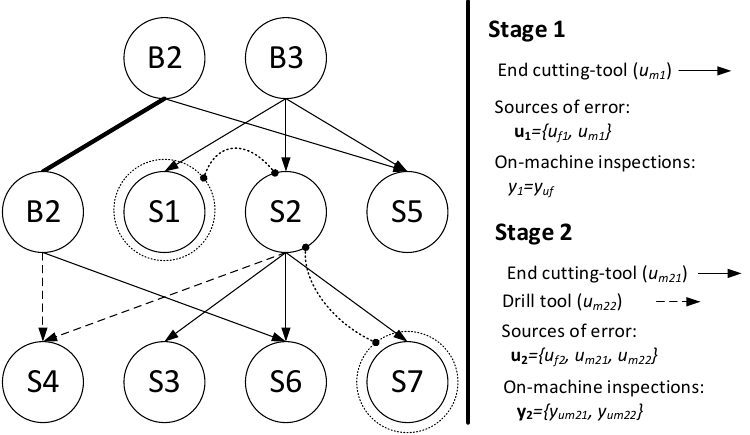
Figure 4. Resulting rooted tree of a previous MMP example. The path related to KPC1 (distance between S1 and S7) is shown in dotted lines to clarify the methodology to obtain the matrix 𝚪 in the text. B2–B3, raw surfaces; S1–S7, machined surfaces.